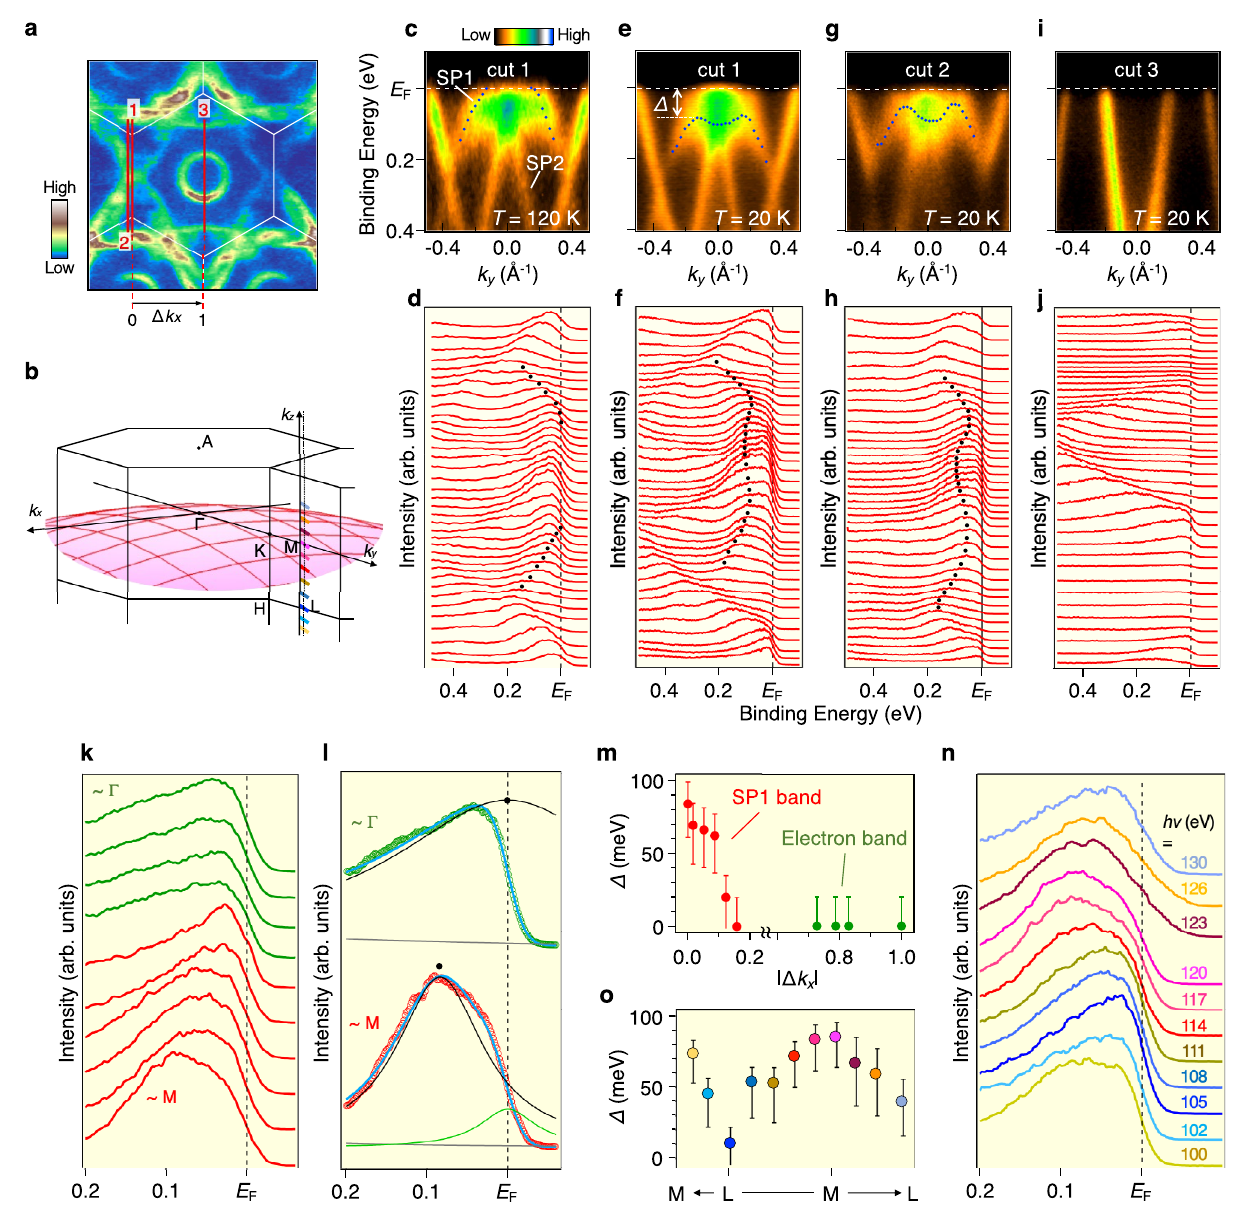
Fig. 2 Momentum dependence of CDW gap in 3D Brillouin zone. a ARPES intensity map at E F at h ν = 114 eV ( k z ~ 0 plane; same as Fig. 1e), together with k cuts where high-resolution ARPES measurements were performed (dashed red curves: cuts 1 – 3). | Δ k x | is de fi ned as the k x value at the measured k point/ cut relative to that at the M point. The Γ M length was set to be a unity. b Bulk Brillouin zone of KV 3 Sb 5 . Purple shade and colored horizontal lines indicate the k z = 0 plane and the k cuts where the EDCs shown in n were obtained, respectively. c , d ARPES intensity and corresponding EDCs along cut 1 measured at T = 120 K. e , f Same as c , d but measured at T = 20 K. g – j Same as e , f but measured along cut 2 ( g , h ) and cut 3 ( i , j ). Blue and black dots in c – h Show experimental band dispersions obtained by tracing the peak position in EDCs; note that the dots in c , d were obtained by tracing the peak position in EDCs divided by the Fermi-Dirac distribution function at T = 120 K convoluted with the energy resolution. The de fi nition of the CDW-gap size Δ is shown in e . k A set of EDCs at T = 20 K extracted at the k points where the leading edge shows a smallest shift relative to E F along each cut (minimum gap locus). l EDCs near the Γ and M points (green and red circles, respectively) together with the result of numerical fi tting (light blue curve) assuming multiple Lorentzian peaks (black, green, and purple curves) multiplied by Fermi-Dirac distribution function (see Supplementary Note 4 for details). Black dots show the peak position of the Sb- p z band near the Γ point and the SP1 band near the M point. m Plot of estimated energy gap against | Δ k x |. n h ν dependence of the EDCs at the minimum gap locus of the MK cut in the surface Brillouin zone. o Gap size plotted against k z estimated from the peak position of EDCs in n . Error bars in m , o re fl ect standard deviations in the numerically simulated E F position and peak position of both calculations predict main bands with a strong intensity experimental data, it may be useful to look at the ( E , k ) region showing a broad correspondence with the original bands in the where two models show a critically different spectral behavior, normal state (dashed green curves) as well as several weak sub- rather than to examine the overall agreement/disagreement of the bands associated with the CDW-induced band folding. Thus, in valence-band dispersion. We found that the prominent difference order to distinguish an appropriate model that reproduces the in the calculated band structure is seen around the M point near